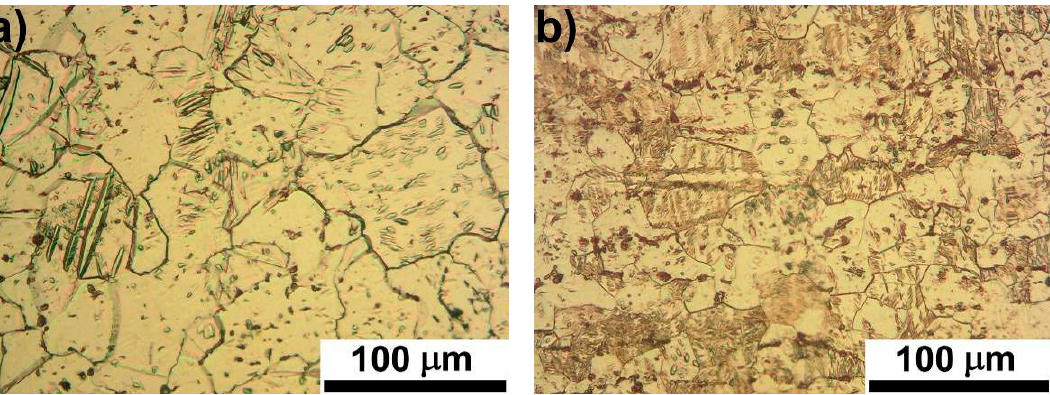
Figure 1. Samples of microstructures revealed by etching, Ti Gr4 as-received state, light microscopy: ( a ) transverse section, ( b ) longitudinal section.